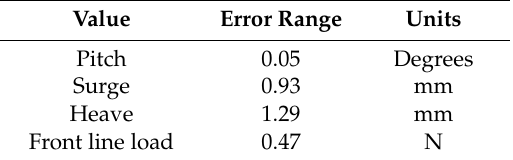
Table 2. Noise on measurement signals at equilibrium. All values are in model scale.